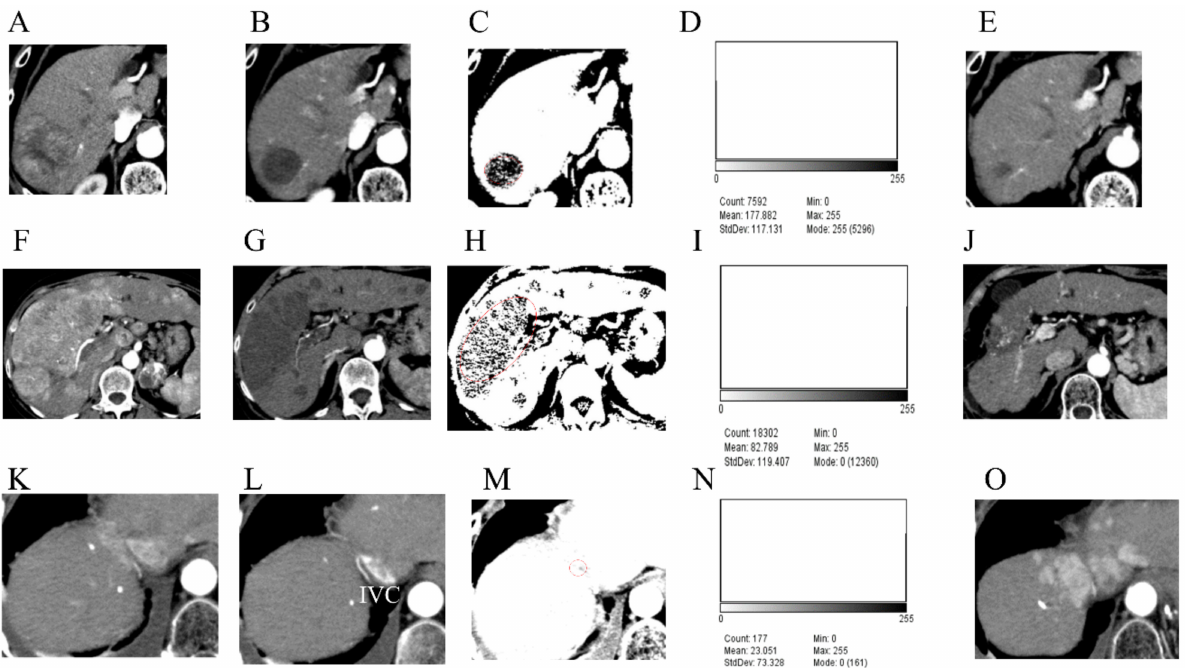
Figure 4. The occupancy rates of CT attenuation values (30 HU) that are predictive of necrosis (N30-CTav) following lenvatinib treatment in three hepatocellular carcinoma (HCC) cases and their subsequent outcomes. Arterial phase of computed tomography (CT) before lenvatinib treatment ( A , F , K ) and on the day of defining the case as achieving a complete response (CR) after lenvatinib treatment ( B , G , L ). Binarized images based on N30-CTav on CT images obtained on the day of definition as CR ( C , H , M ). Histograms showing the occupancy rate of CTav of below 30 HU (N30- CTav) ( D , I , N ). CT images 1 year ( E ), 2 years ( J ), and 3 months ( O ). after the day of definition as CR. N30-CTav, a CTav of 30 HU was set as the threshold for histological necrosis. Red circles: target tumor area where CR was obtained. IVC, inferior vena